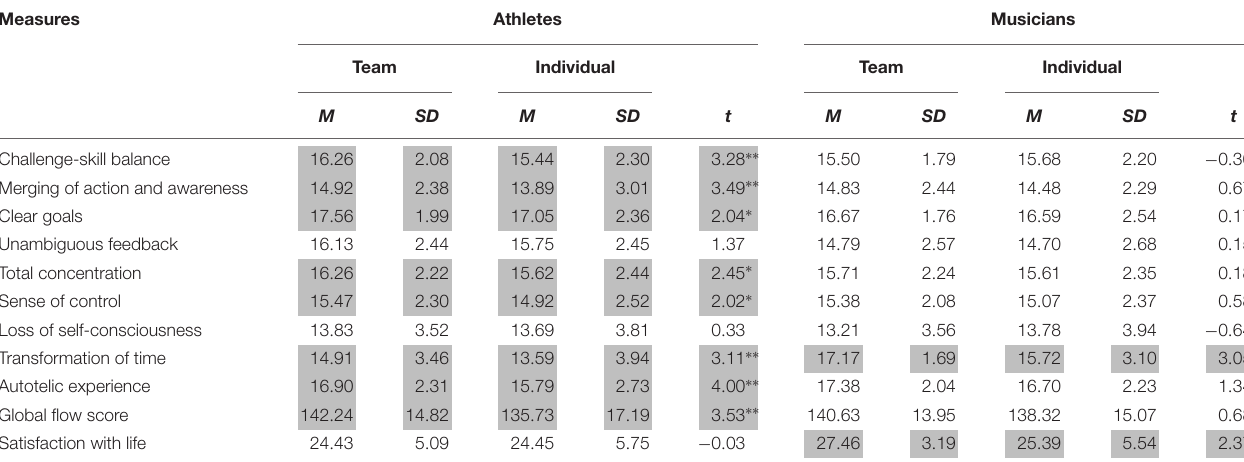
TABLE 3 | Comparison of team and individual performers in musicians and athletes in flow dimensions and satisfaction with life.